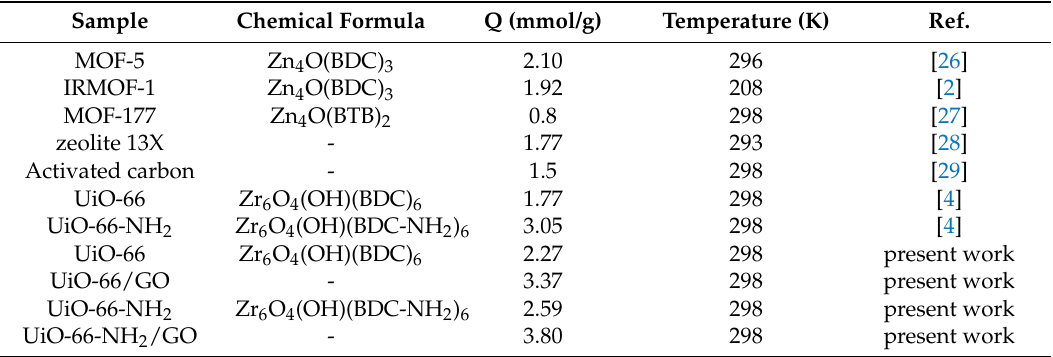
Table 2. Adsorption capacity of the prepared composite and some other adsorbents for selected CO 2 reported from the literature at 1 bar.